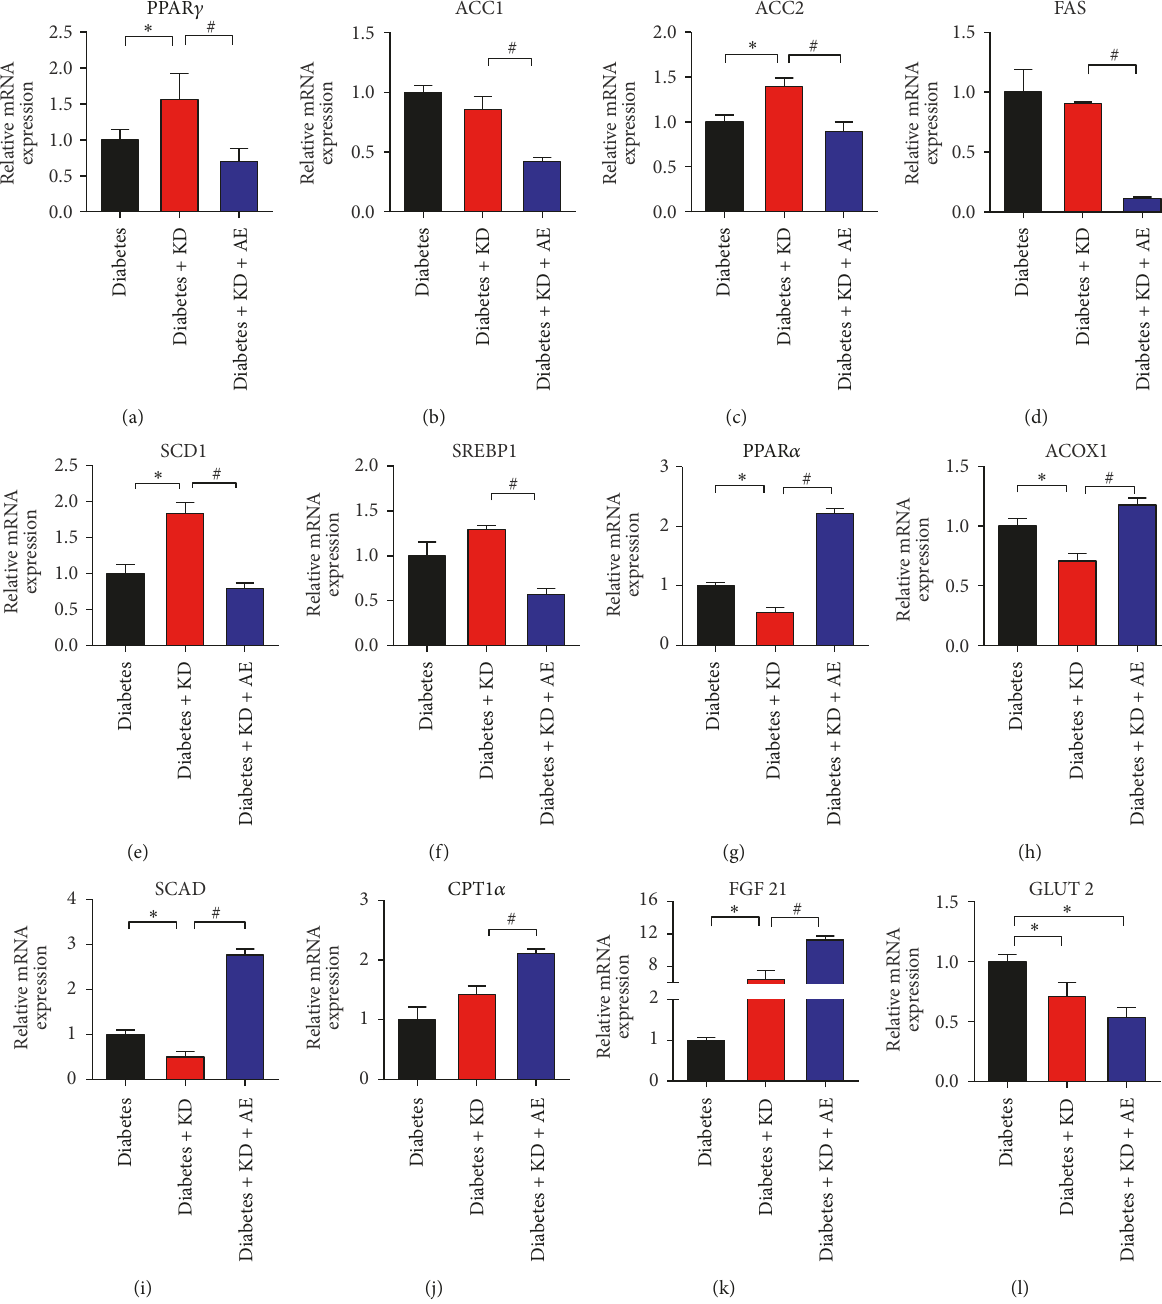
Figure 6: Aerobic exercise modulates PPAR 𝛼 and PPAR 𝛾 gene programs in the mice liver. Gene expression of (a) PPAR 𝛾 and (b)–(f) its target genes in mice livers from diabetic group, diabetes + KD and diabetes + KD + AE groups, after 6-week diet and exercise intervention. Gene expression of (h) PPAR 𝛼 and its target genes (g)–(j) in mice livers, from diabetic group, diabetes + KD and diabetes + KD + AE groups, after 6-week diet and exercise intervention. Gene expression of (k) FGF 21 and (l) GLUT2 is presented, after intervention. Results were examined by real-time PCR. Data were presented as means ± SEM ( 𝑛 = 6 per group) and statistical analysis was performed with 1-way ANOVA. ∗ 𝑃 < 0.05 versus diabetic group and # 𝑃 < 0.05 versus diabetes + KD